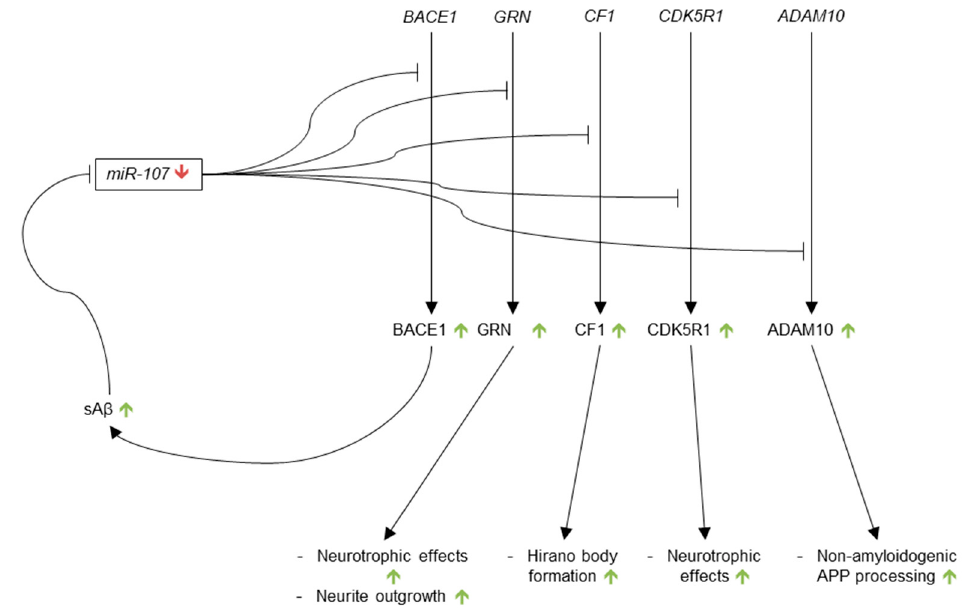
Figure 6. Regulation by miR-107. miR-107 inhibits the translation of BACE1, GRN, CF1, CDK5R1, and ADAM10. The red arrow indicates the downregulation of miR-107 observed in AD brain. The green arrows indicated the hypothetically increased levels of the proteins targeted by miR-107, as well as their cellular effects.